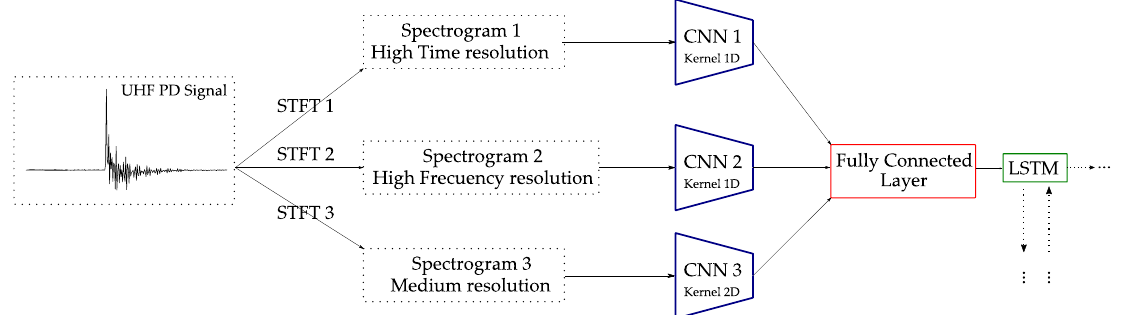
Figure 10. CNN subnetworks proposed by [24] with di ff erent input data representation of the UHF PD signal.